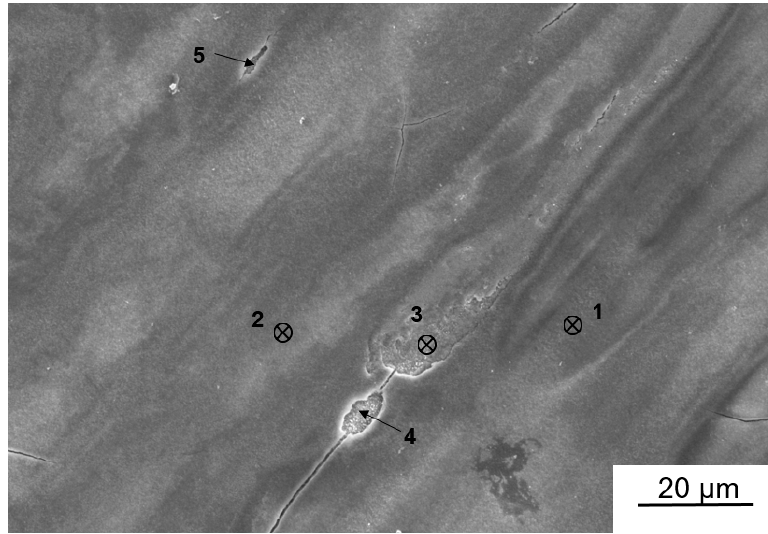
Figure 10. SEM micrograph taken from surface of Al-30wt %Sn-10wt %Zn processed by HPT for N = 20 after immersion in water for 1 min at room temperature. Numbers correspond to points for EDS analysis with results as in Table 2. Table 2. EDS results (in wt %) for selected areas in Figure 10. Regions 1 and 2 correspond to matrix and regions 3, 4, and 5 correspond to pits.